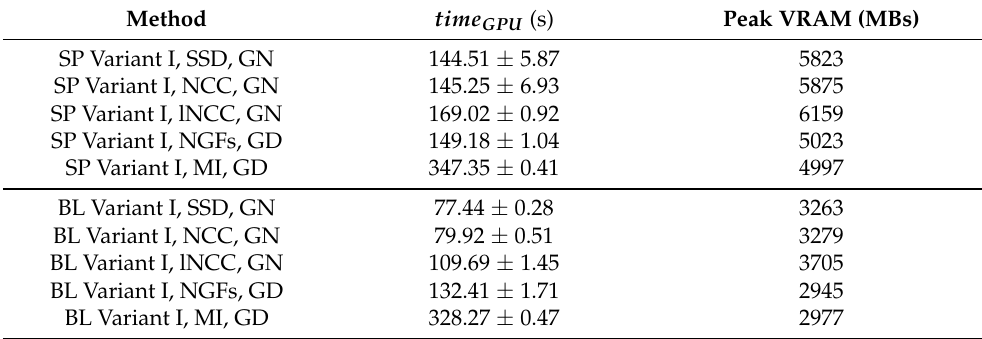
Table 4. NIREP16. Single-resolution experiments. Mean and standard deviation of the total GPU time, and maximum VRAM memory usage achieved by the methods through the registrations.